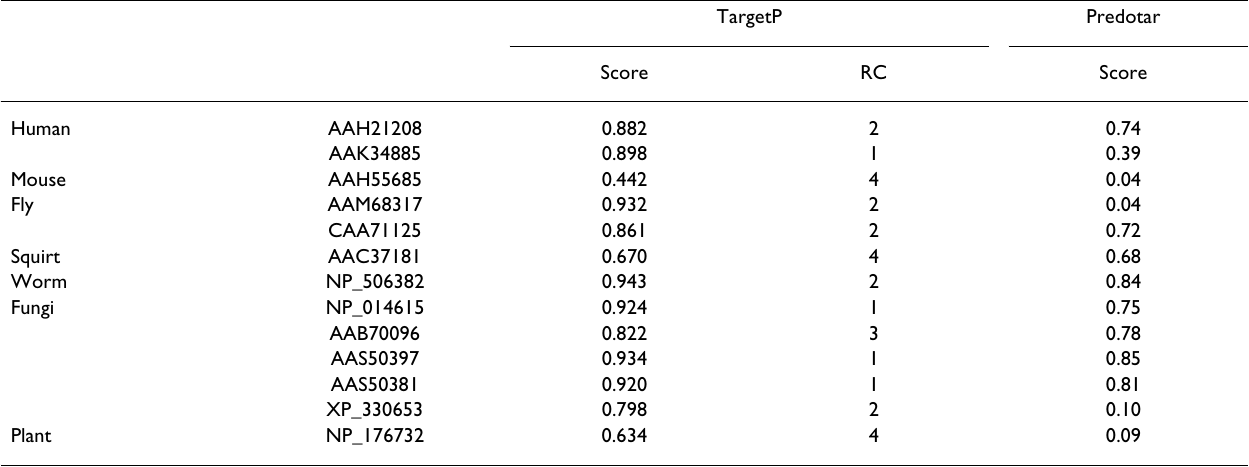
Table 1: Prediction of mitochondrial targeting of HCCR-1 and LETM1 domain-containing